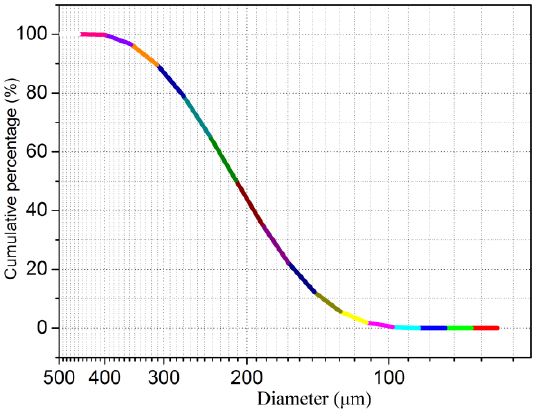
Figure 4. Size distribution of SS.